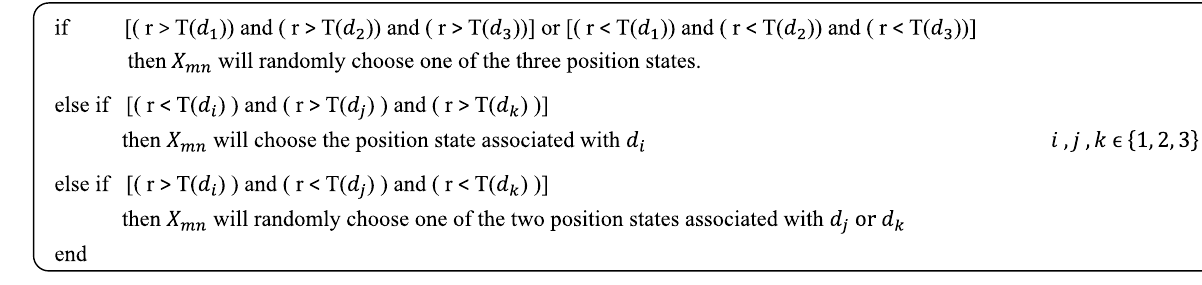
Figure 2. The procedure of updating particles’ position in the TPSO